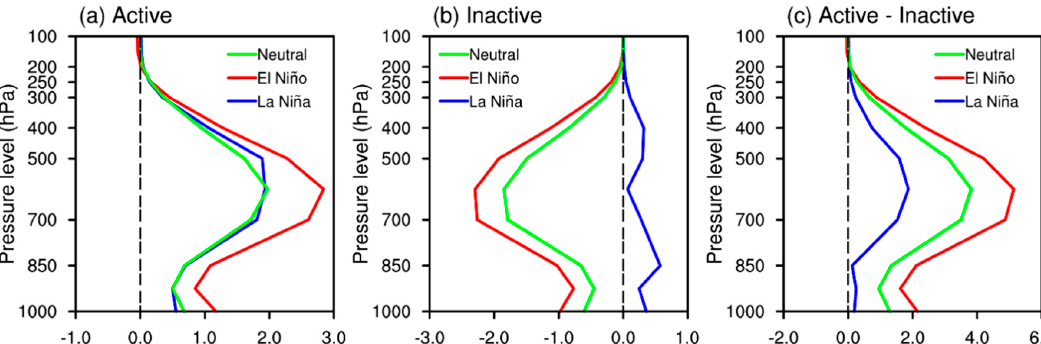
Figure 12. Composite vertical profiles of region-averaged filtered specific humidity anomalies (unit: 10 − 1 g·kg − 1 ) during the ( a ) active and ( b ) inactive MJO phases; ( c ) differences between phases in neutral years (green), the El Niño years (red), and the La Niña years (blue) over the WNP during June–November over the period of 1979–2016. The definition of the active and inactive phases for the MJO-related WNP TC genesis under different ENSO conditions is in Table 1.